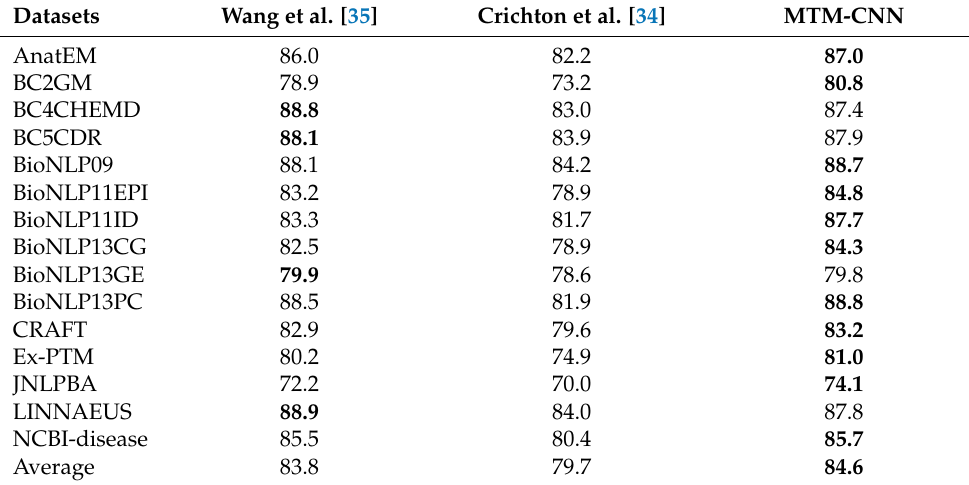
Table 3. Results comparison for different multitask